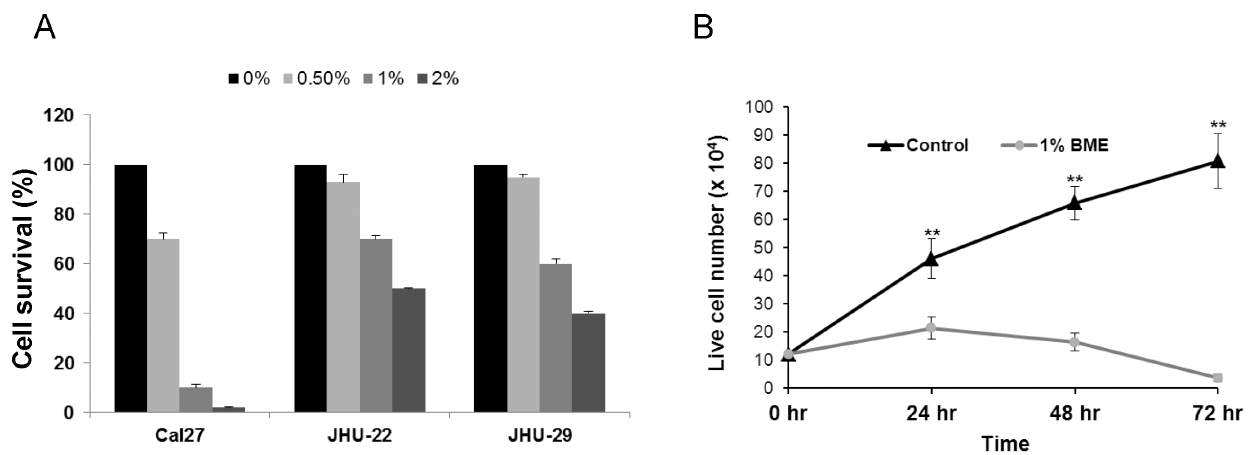
Figure 1. BME treatment in HNSCC cells inhibits proliferation. (A). HNSCC cells were treated with BME for 24 h, and MTS assay was performed. (B). Cal27 cells were treated with BME for different time points. Cell proliferation was measured in control and BME treated Cal27 cells by Trypan blue exclusion method. The results are presented as means of three different experiments with standard errors. (**, p , 0.001).